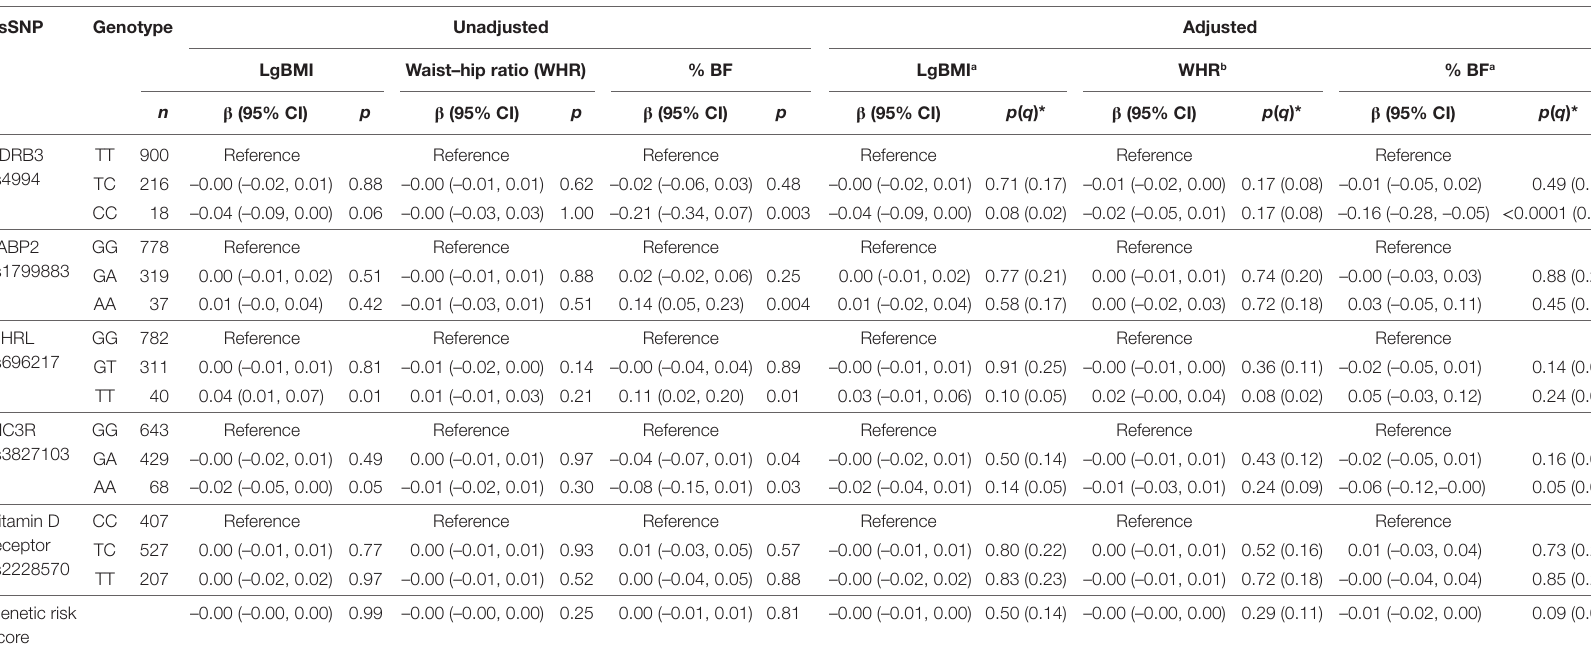
TaBle 3 | Association between selected non-synonymous single-nucleotide polymorphisms (nsSNPs) and adiposity parameters in Malaysian Health and Adolescents Longitudinal Research Team study adolescents presented as β with 95% confidence interval (CI) and p values [uncorrected and corrected ( q )].